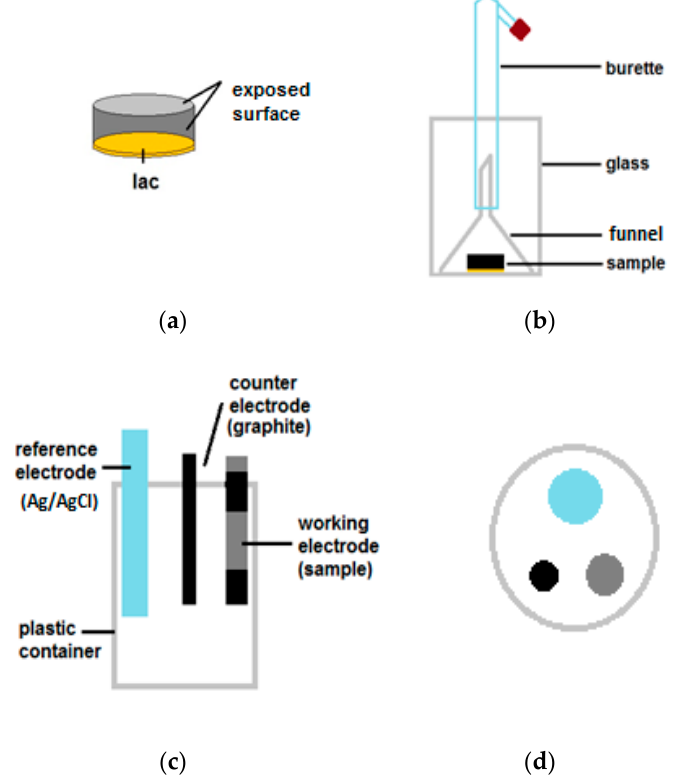
Figure 1. Scheme of hydrogen release set up, adapted from reference [31] ( a–d ) electrochemical cell, adapted from reference [32].